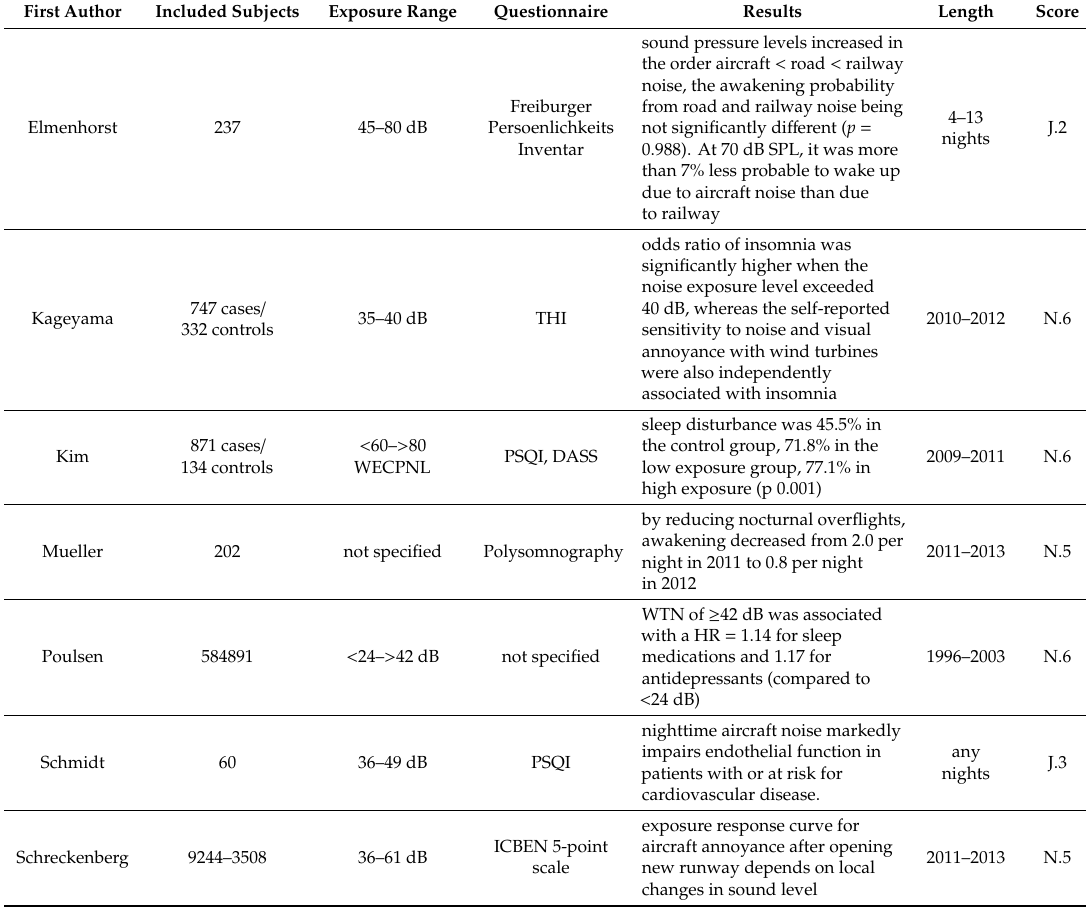
Table 5. Experimental, case-control, cohort study, with their relative